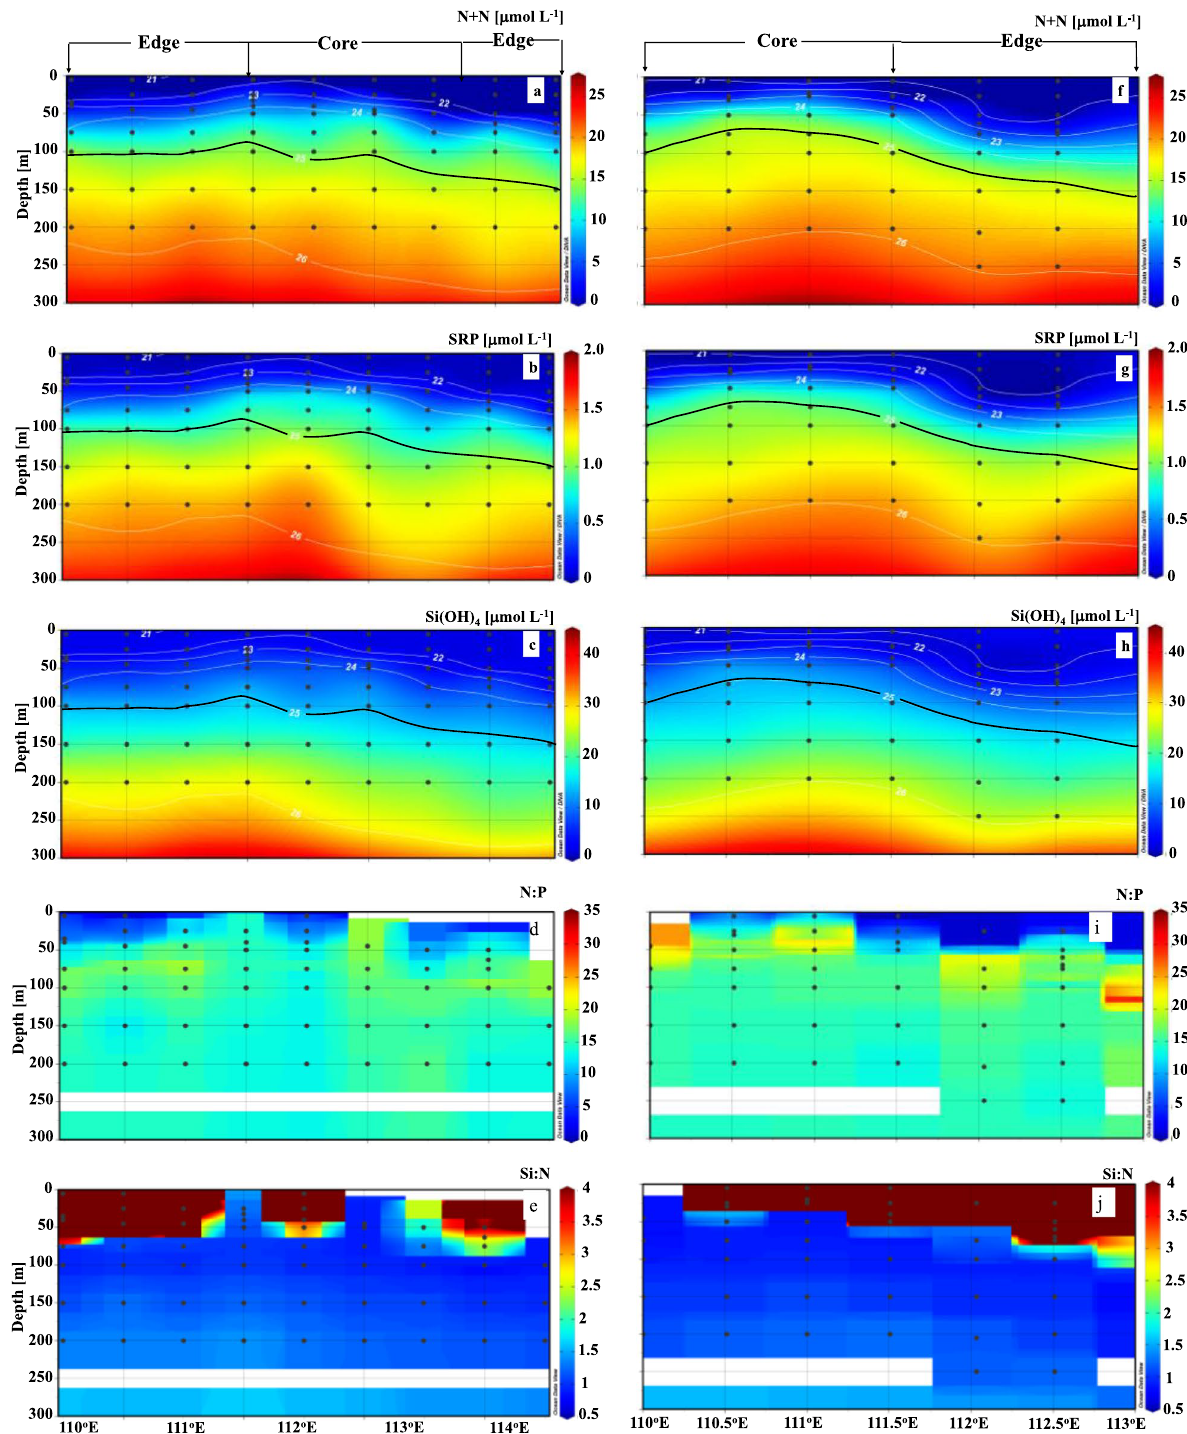
Fig. 2 Sectional distributions of N N, SRP, Si(OH) 4 , dissolved N:P and Si:N ratios in the upper 300 m in decay eddy (left panel) and mature eddy + (right panel) (see Fig. 1 for the locations of the transects). Core and edge stations are denoted at the top. The isopycnal lines of σ θ highlighted in